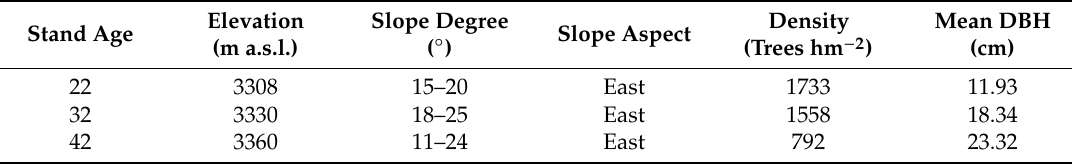
Table 1. Basic characteristics of the three P. asperata